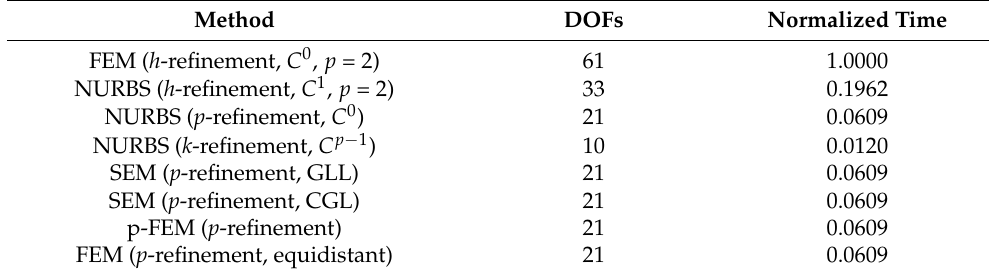
Table 2. Different approaches and their corresponding normalized time and required DOFs when the relative error is less than 6 × 10 − 4 % Method DOFs